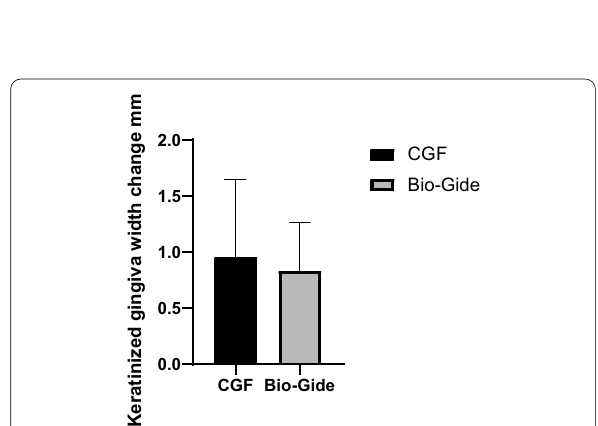
Fig. 6 Comparison of changes in wound healing rate at 3, 7 and 14 days after ARP (* P < 0.05**, P < 0.001)